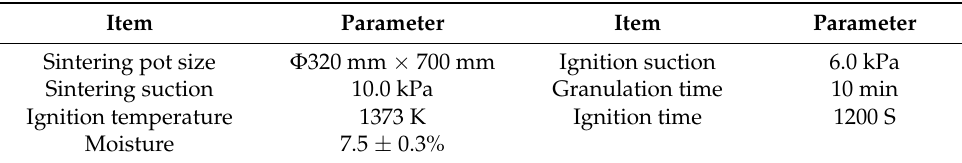
Figure 1. Schematic of sintering pot test equipment. Table 3. Parameters of the sintering test.